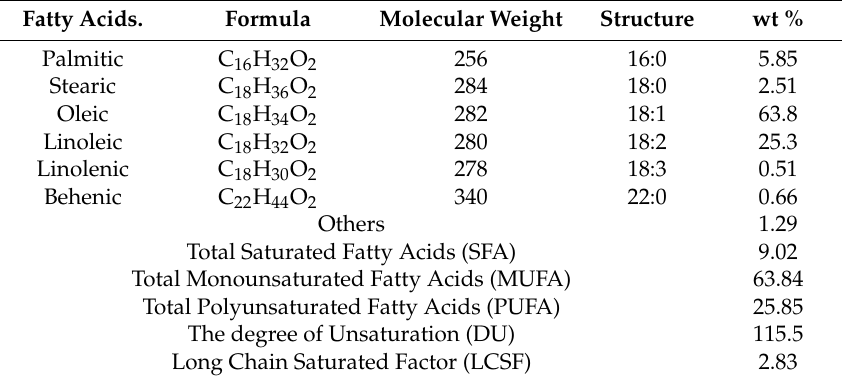
Table 4. The fatty acid composition of SFO. Fatty Acids.